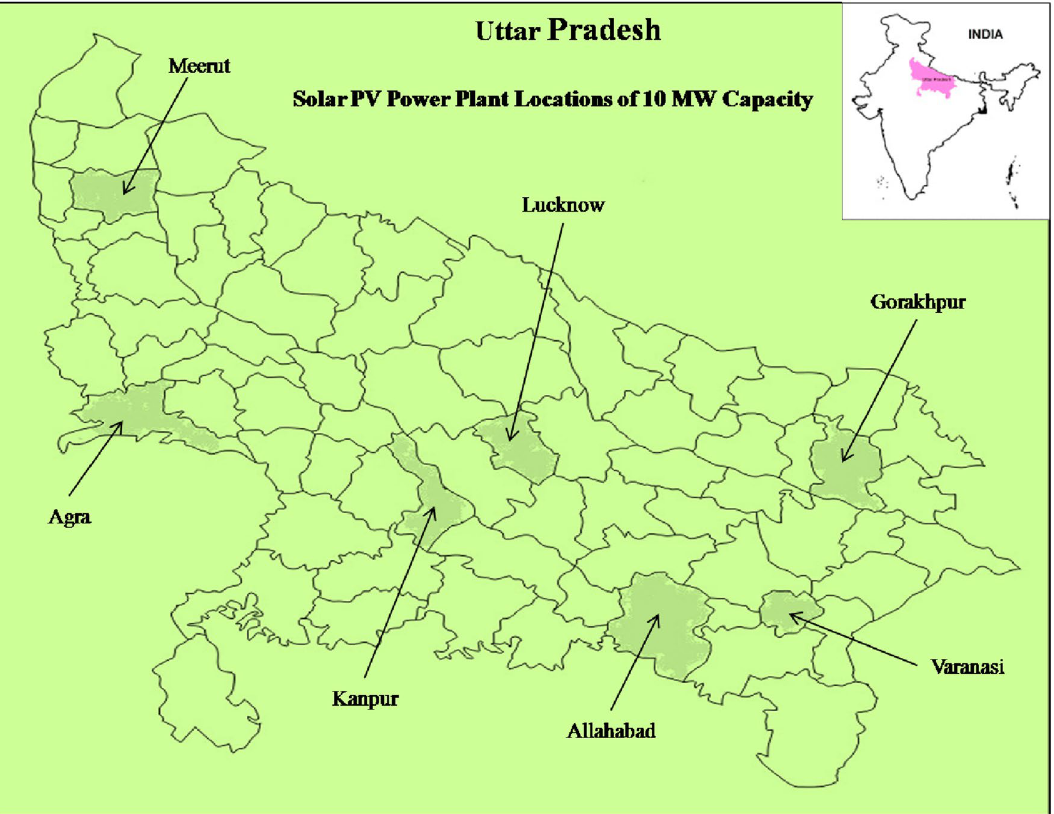
Figure 3. Proposed Solar PV power plant locations of UP India (https://d- maps. com/ carte. php? num_ car= 9181& lang= en).